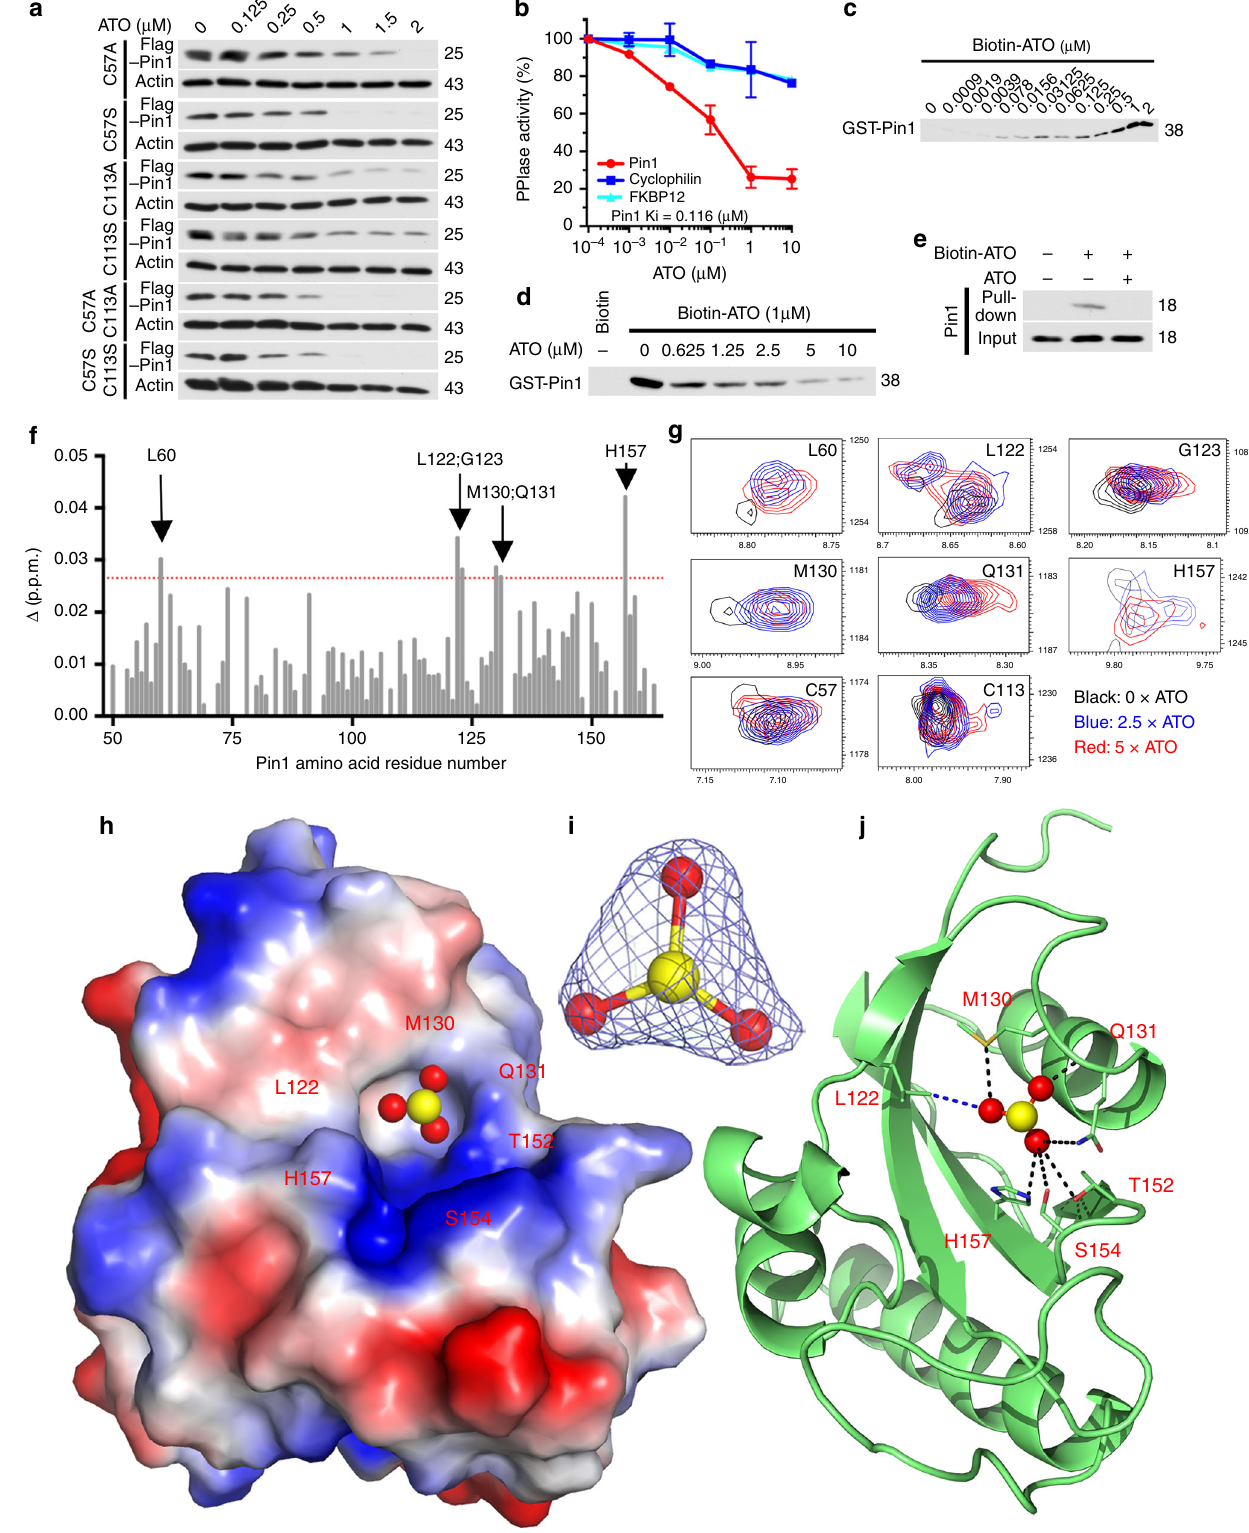
Black: 0 × ATO Blue: 2.5 × ATO Red: 5 ×